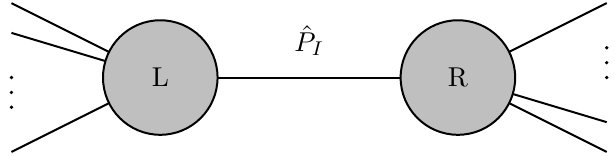
Figure 1 . Complex shifts of the external kinematics can be used to write recursion relations for amplitudes. Here we show the contribution from the z factorizes into two on-shell sub-amplitudes ˆ A